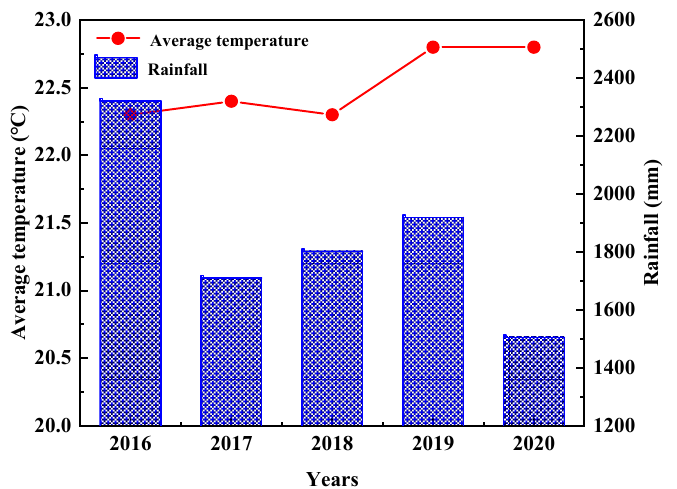
Figure 1. Climate characteristics of Guangdong Province from 2016–2020. (Adapted from ref. [3])